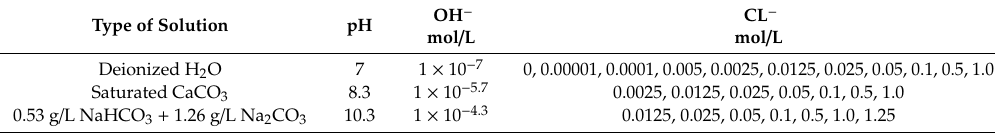
Table 2. Details of simulated concrete pore solutions used in